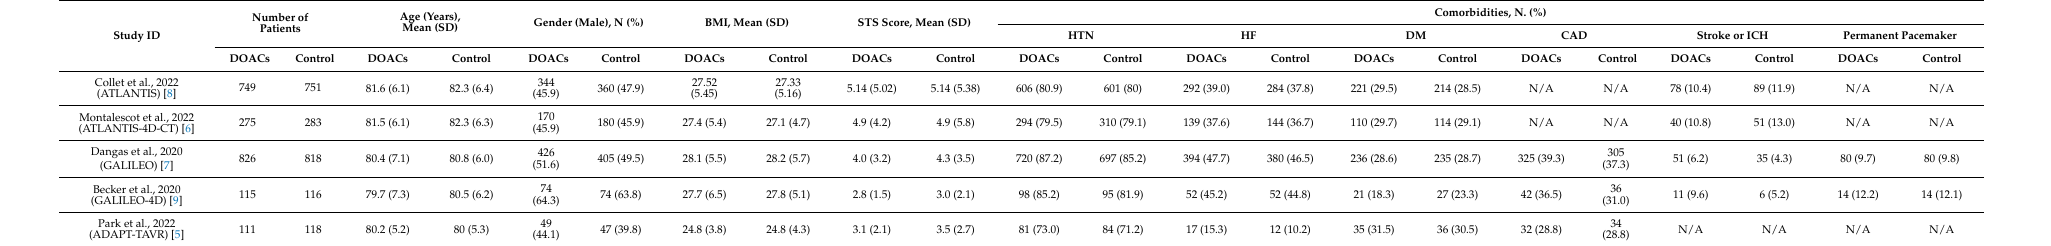
Table 3. Baseline characteristics of the